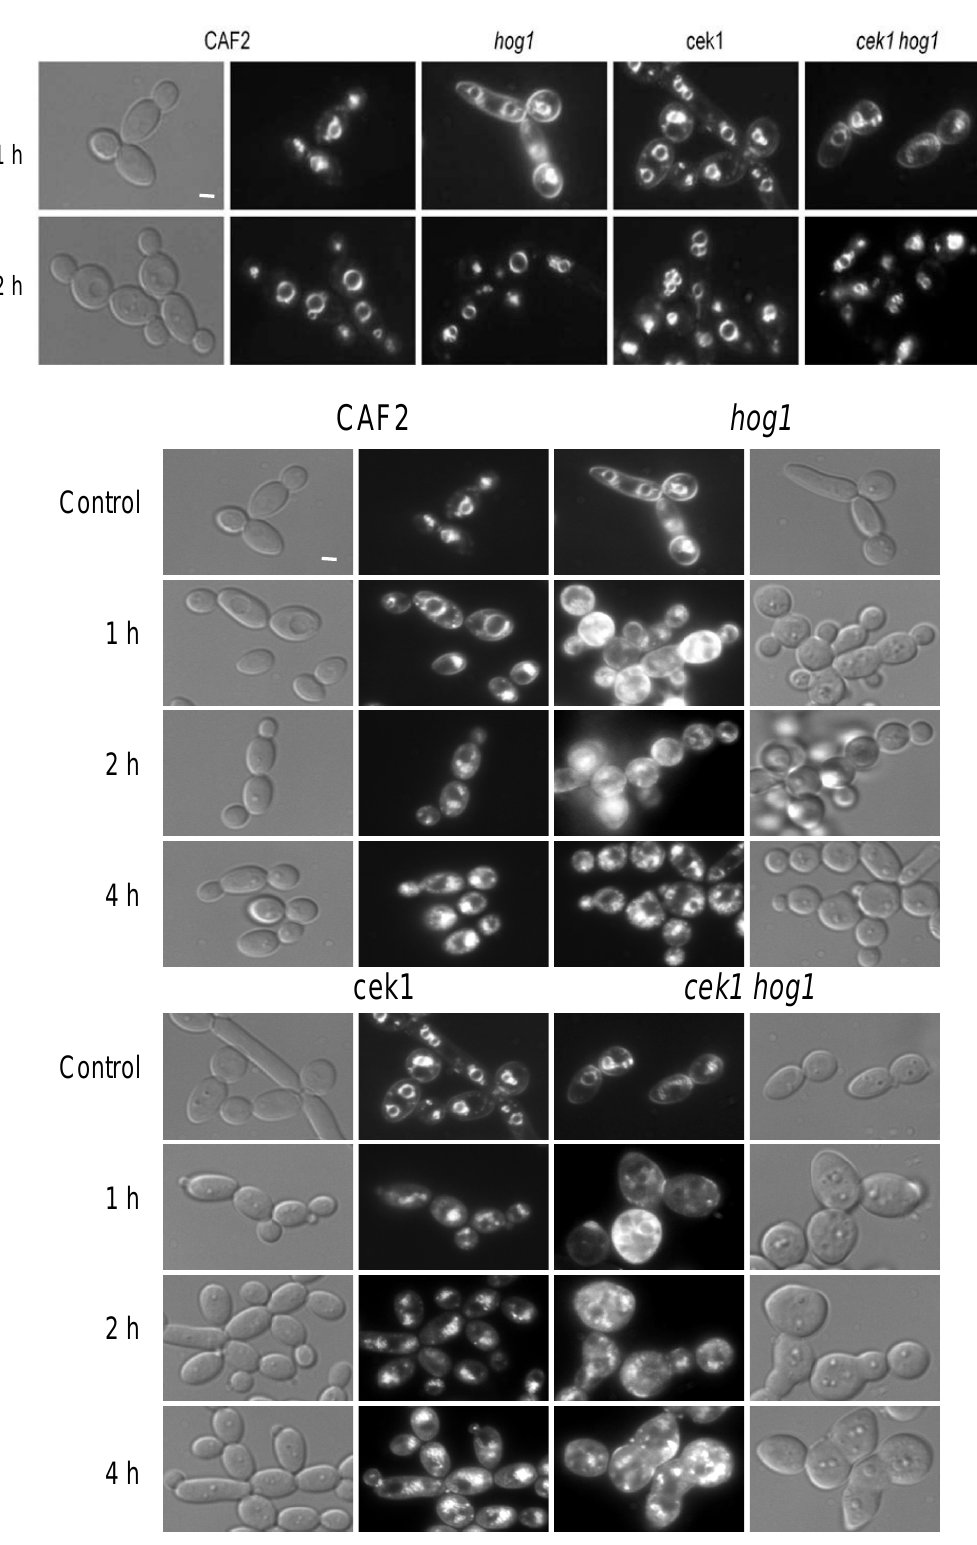
Figure 3. Endocytic tra ffi cking. ( a ) FM4-64 dye was added to cells growing in YPD at 37 ◦ C to visualize its internalization. Pictures were taken 1 and 2 h after dye addition using a Normasky and fluorescence microscopy. ( b ) Cells incubated for 20 h in YPD plus 1 M NaCl at 37 ◦ C were stained with FM4-64 and samples were taken at the indicated time points. Control panel belongs to the same strain stained with the dye for 1 h in YPD medium. Bars, 1 µ